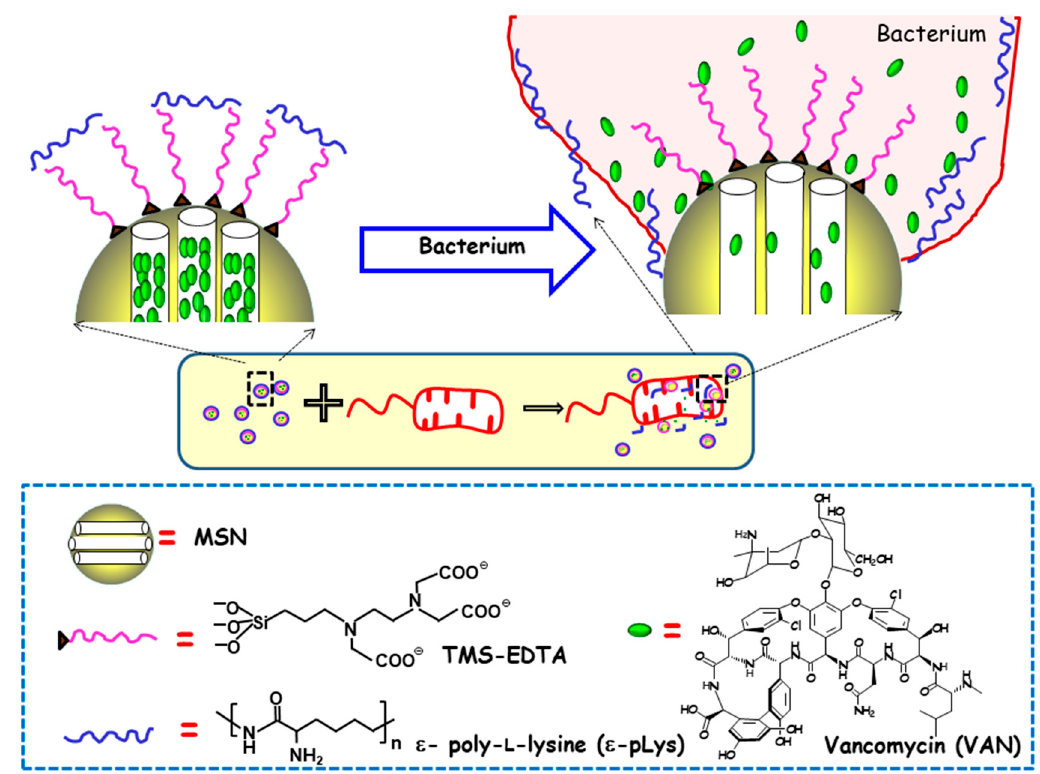
Figure4. Schematicdepictionoftheactionmechanismofbacterium-triggeredantimicrobialnanosystemswas Figure 4. Schematic depiction of the action mechanism of bacterium-triggered antimicrobial composed of MSNs loaded with vancomycin (VAN), functionalized with N-[(3-trimethoxysilyl)propyl] nanosystems was composed of MSNs loaded with vancomycin (VAN), functionalized with ethylendiamine triacetic acid trisodium salt (TMS-EDTA) and capped with ε -poly-L-lysine ( ε -pLys) in N-[(3-trimethoxysilyl)propyl] ethylendiamine triacetic acid trisodium salt (TMS-EDTA) and capped the presence of E. coli. Adapted from ref. [48]. Mesopores capping occurs via electrostatic interactions with ε -poly-L-lysine ( ε -pLys) in the presence of E. coli. Adapted from ref. [ 48] . Mesopores capping between cationic ε -pLys and negatively charged TMS-EDTA. In the presence of bacteria, the adhesion of the ε -pLys gatekeeper with the negatively charged bacteria wall triggers pore uncapping and allows cargo release, as schematically shown as an